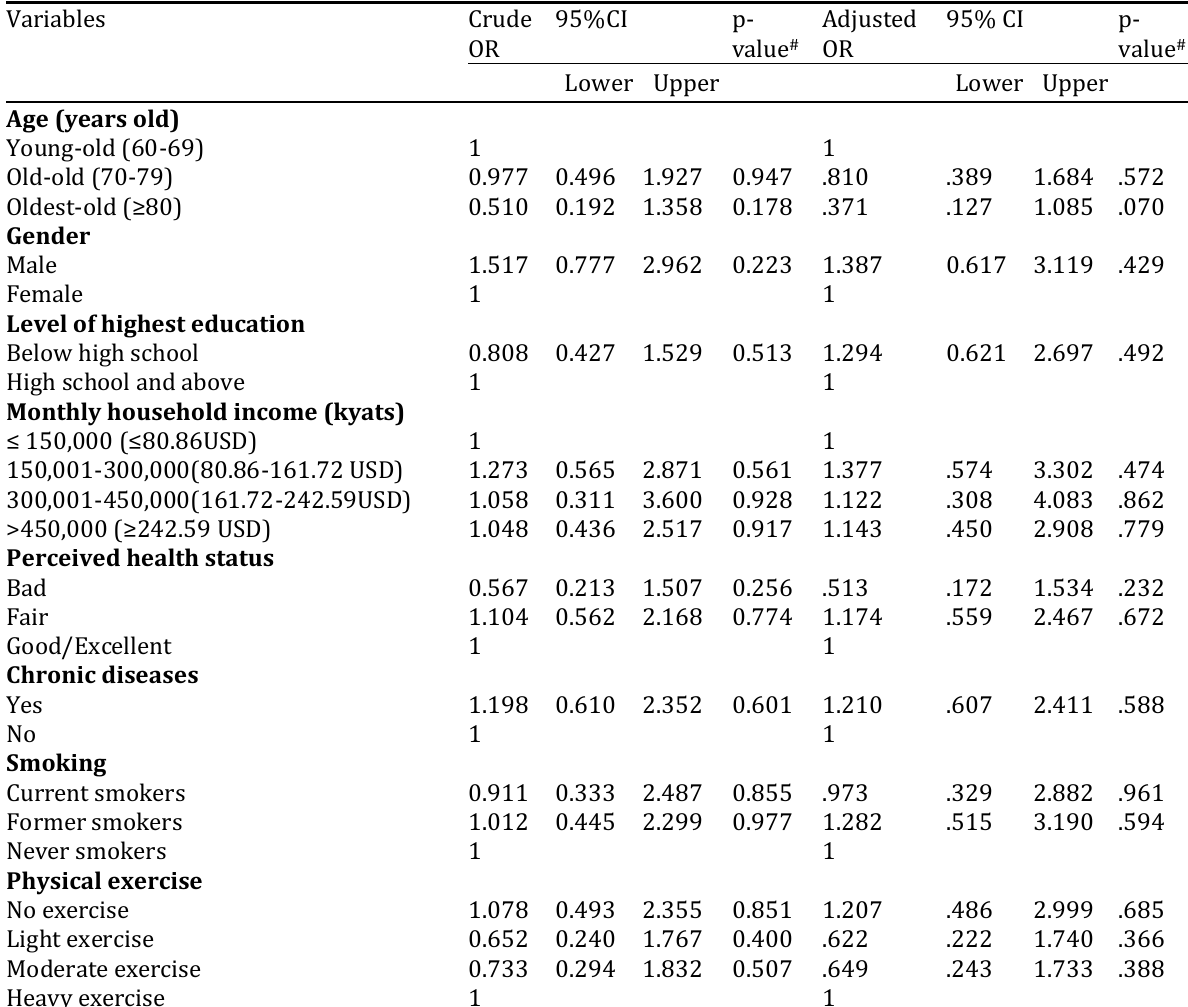
Table 4: Factors associated with DS